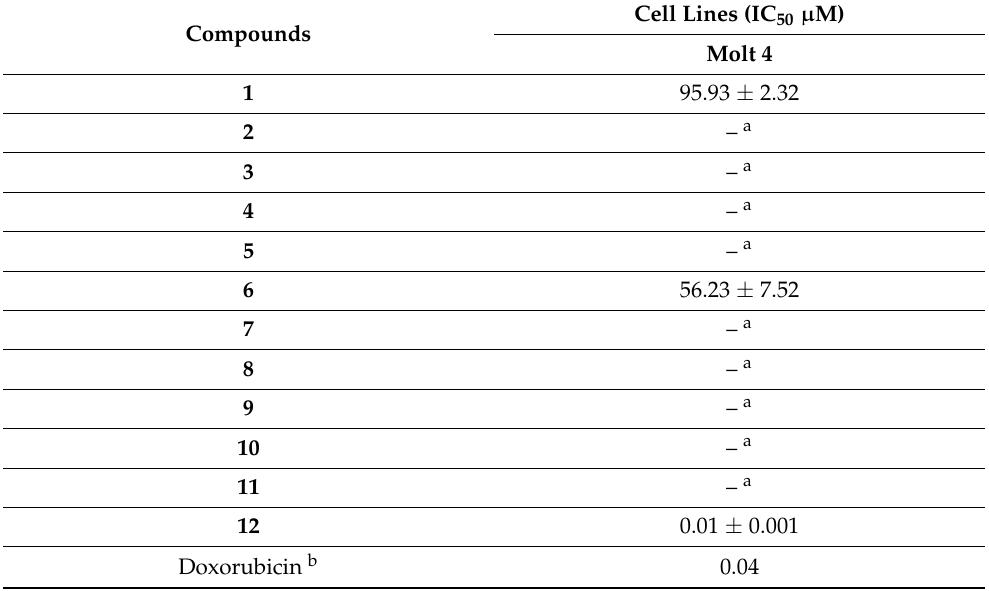
Table 2. Anti-proliferative activity of the isolated metabolites from the ethyl EtOAc extract of Streptomyces sp. LY1209.